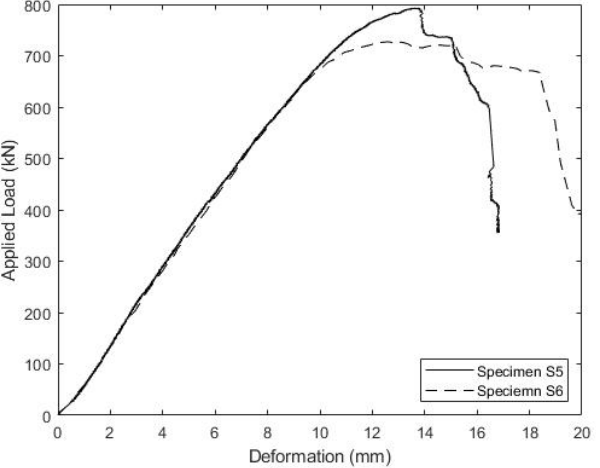
Figure 20. Stainless Steel Connector Load-Deformation Response under Monotonic Loading to